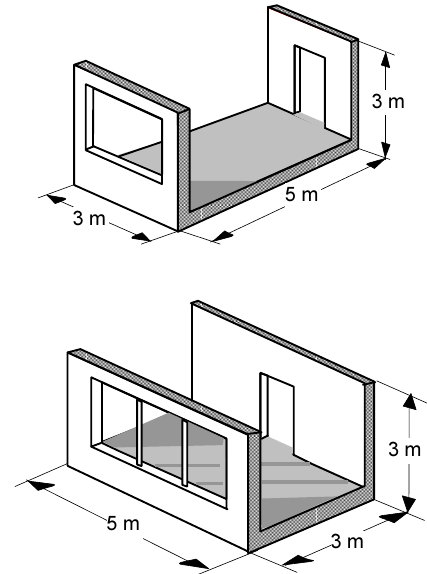
Fig. 1. Top: room type 1; bottom: room type 2 The solar factor g is the ratio of solar heat gain through a glazing to solar heat gain through a single clear glass. The smaller the number, the better the glazing is at preventing solar heat gains but the poorer it is at allowing natural daylight to enter the room (Bergsten